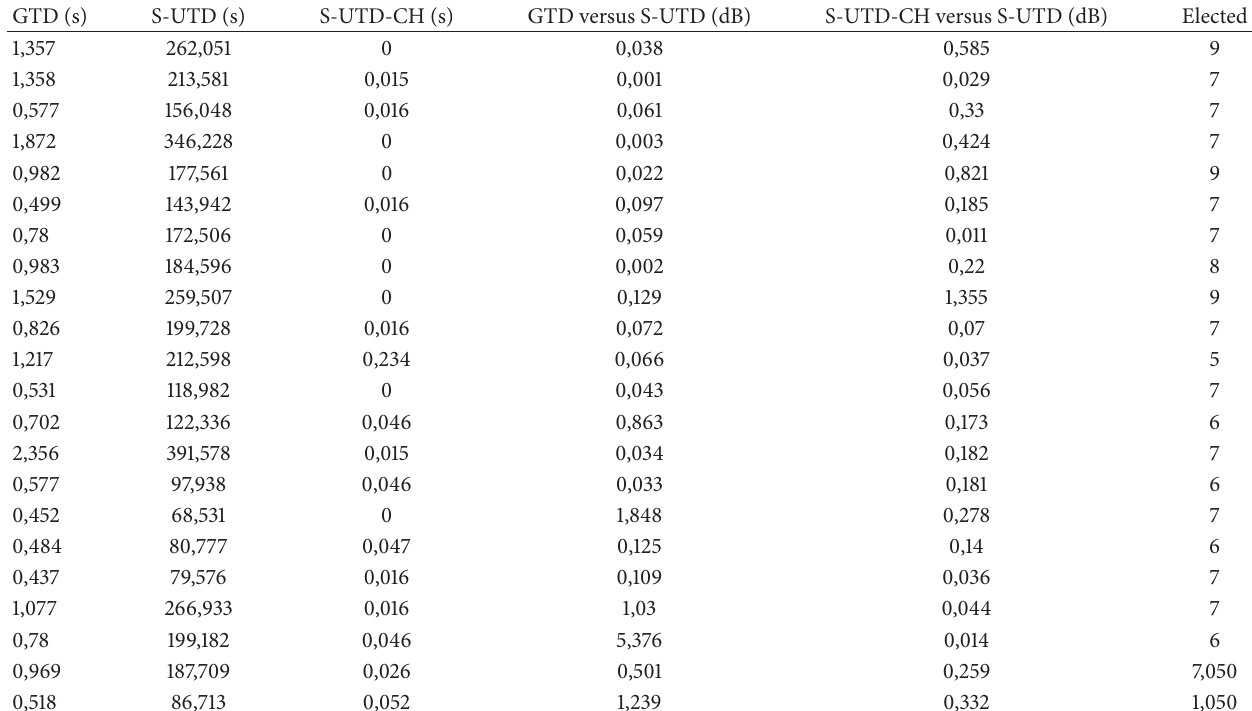
Table 2: Comparison results of elevated receiver height